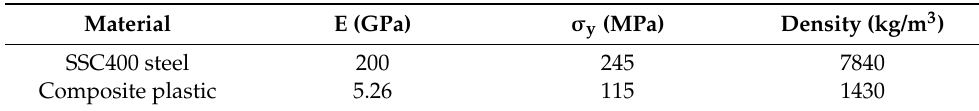
Figure 1. ( a ) Bending test results; ( b ) tensile test results. Table 1. Comparison of the basic properties.